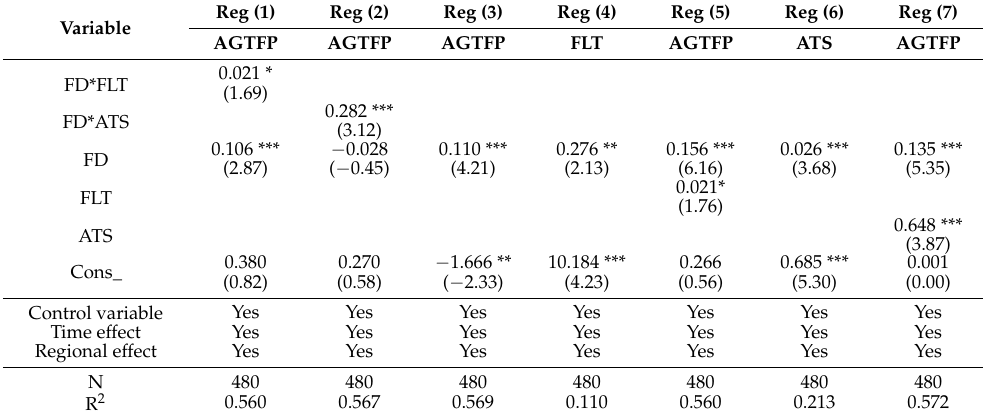
Table 8. Mechanism test